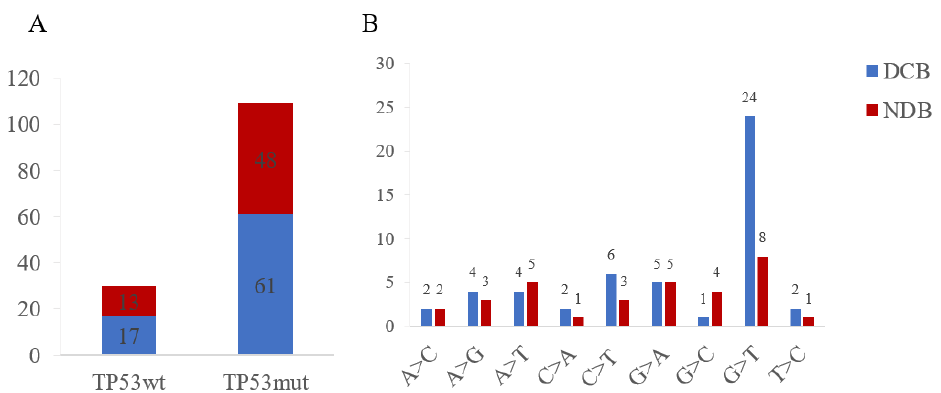
Figure 4. Clinical benefit ( A ) and nucleotide variation ( B ) of TP53wt and TP53mut cohorts. DCB, durable clinical benefit; NDB, no durable benefit.